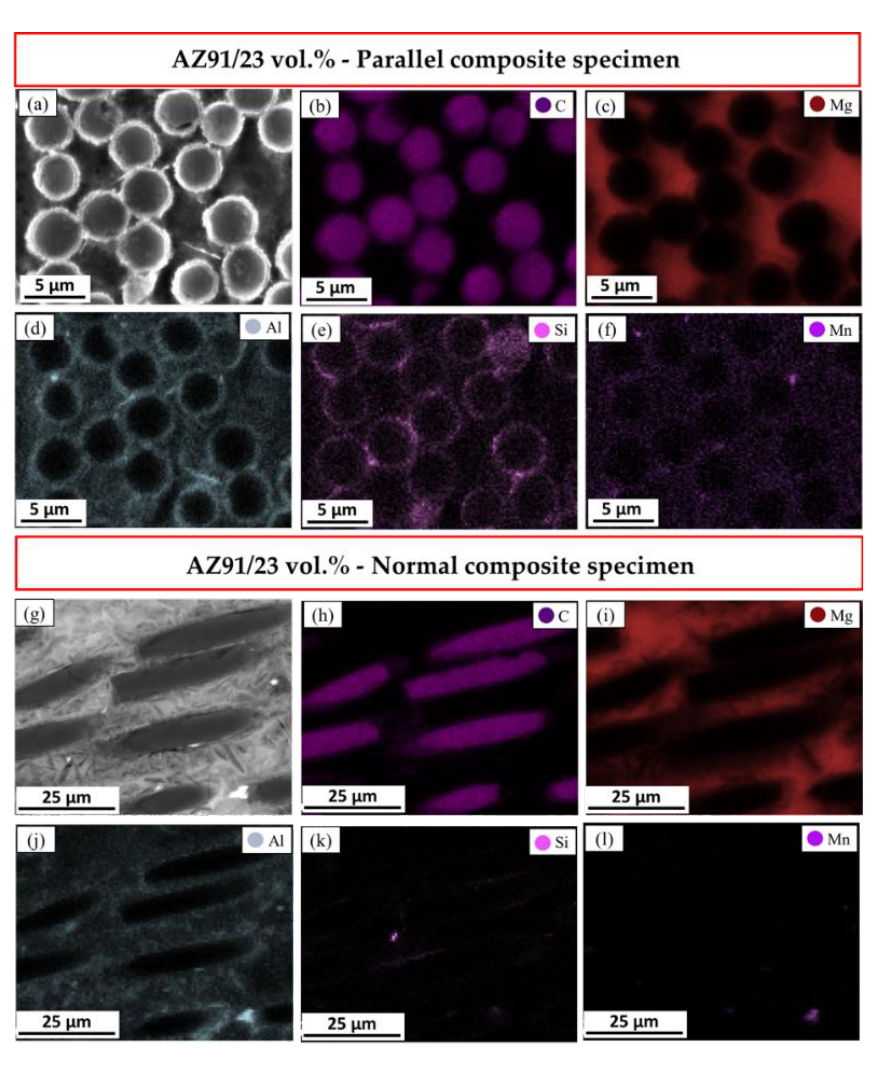
Figure 8. Elemental mapping of AZ91/23 vol.% carbon fiber for the ( a – f ) parallel and ( g – l ) normal composite specimens.